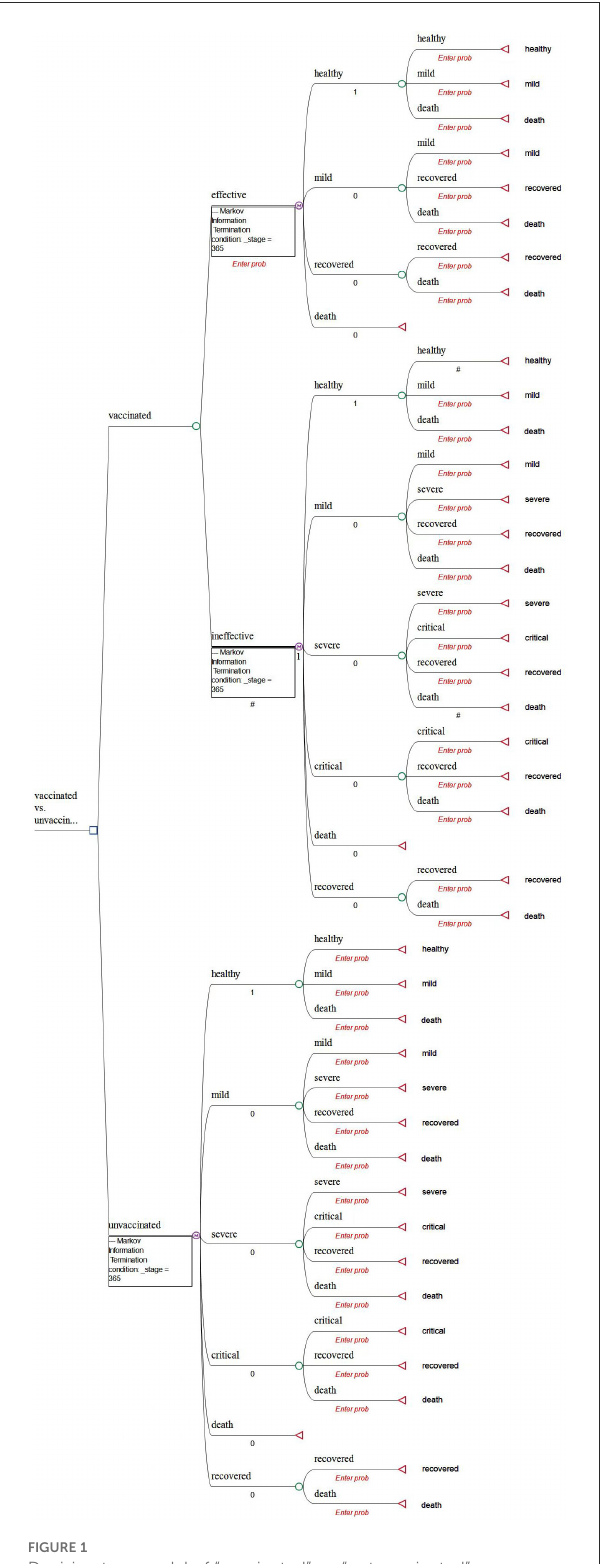
FIGURE1 Decision tree model of “vaccinated” vs. “not vaccinated”.